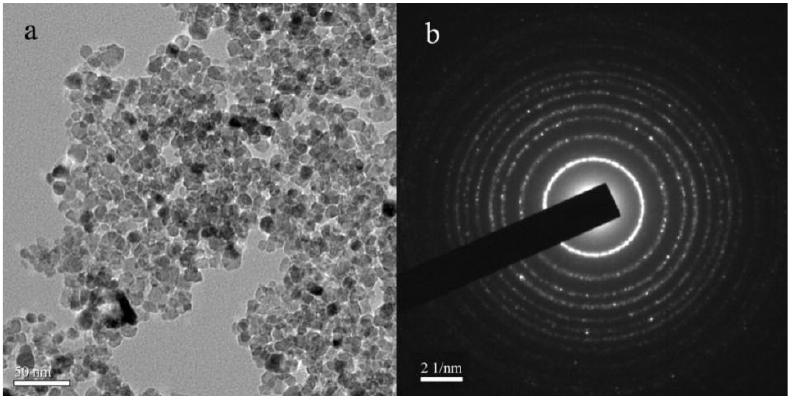
Figure 15. ( a ) The TEM morphology image of N-TiO 2 ; ( b ) The selected-area electron diffraction of N-TiO 2 .